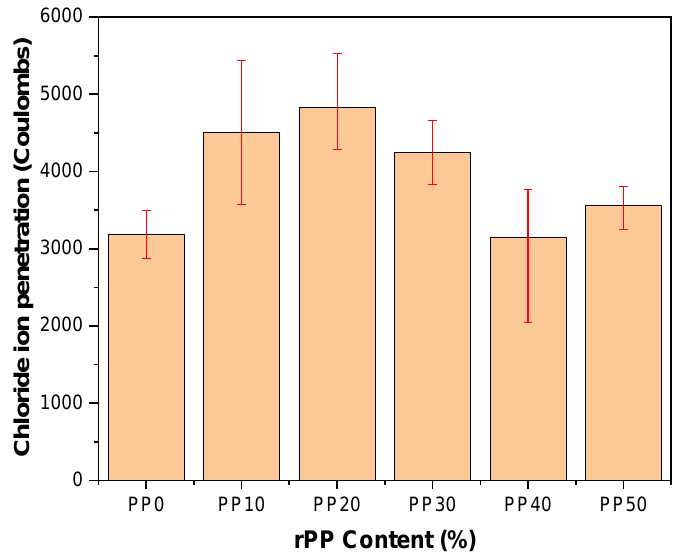
Figure 11. Penetration of chloride ions in mortar mix at the age of 28 days.